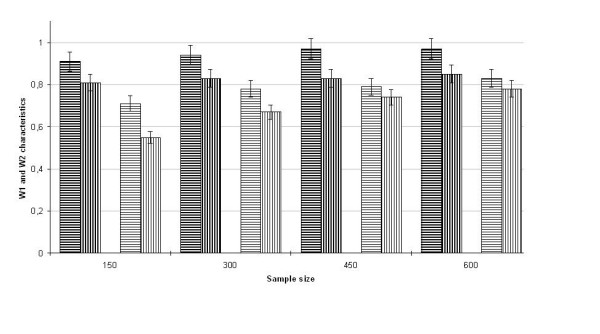
Bar graphs for W1 and W2 statistical characteristics depending on the sample size at the QTL position 10 cM. Bar graphs hatched by bold lines correspond to characteristic W1; bar graphs hatched by thin lines correspond to characteristic W2; vertical lines are intended for the method realized by software Qxpak; horizontal lines are intended for the method proposed in this study.